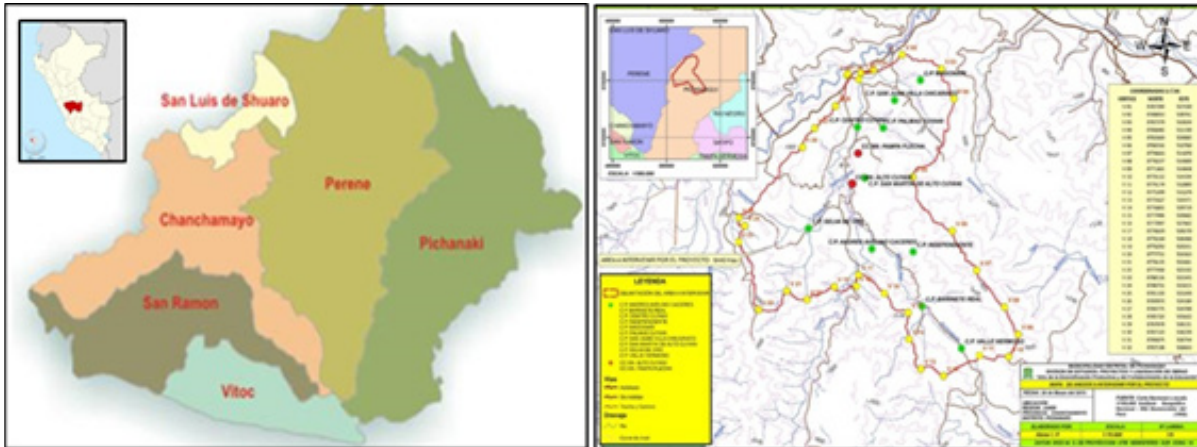
Figure 1. Map of the Pichanaki district and the Cuyani Micro-basin study area, Chanchamayo province, Junín region, Peru (Adapted from: MDP, 2015). The study did not consider the town of Valle